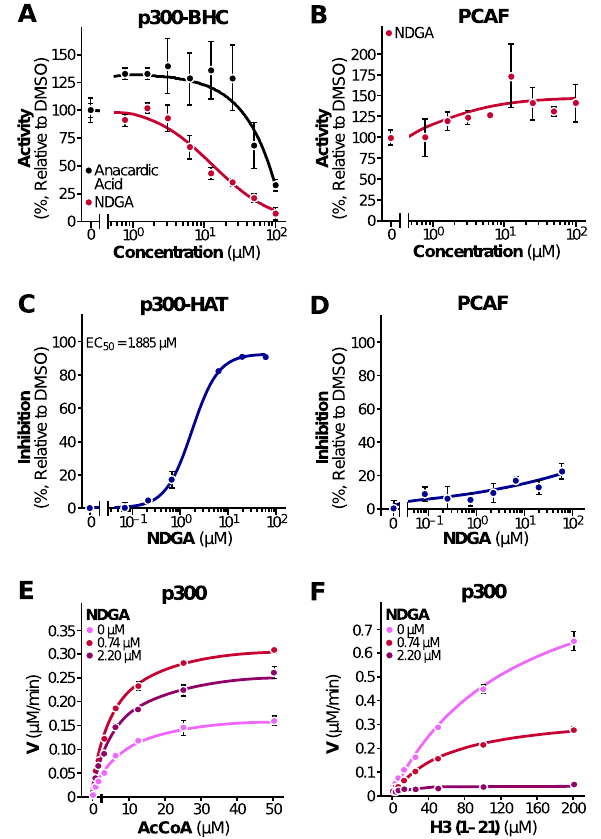
Fig. 1 NDGA inhibits histone acetyltransferase activity of p300 in vitro. a The acetyltransferase activity of p300 on histone H3 peptide (aa 1 – 21) was measured in the presence of NDGA or anacardic acid. Results are expressed as percentage activity in the absence of NDGA. A paired t -test was performed for statistical signi fi cance, p = 0.0013. b Effect of NDGA on PCAF HAT activity expressed as percentage activity in the absence of NDGA. Inhibitory effects of NDGA on p300 ( c ) and PCAF ( d ) using another enzymatic assay were measured and are expressed as percentage inhibition relative to control DMSO. Effects of varying concentrations of acetyl- CoA ( e ) and substrate peptide histone H3 in the presence of varying concentrations of NDGA were measured ( f ). Data represent the results from three independent experiments (mean ± S.D.), and curves were generated using nonlinear regression fi